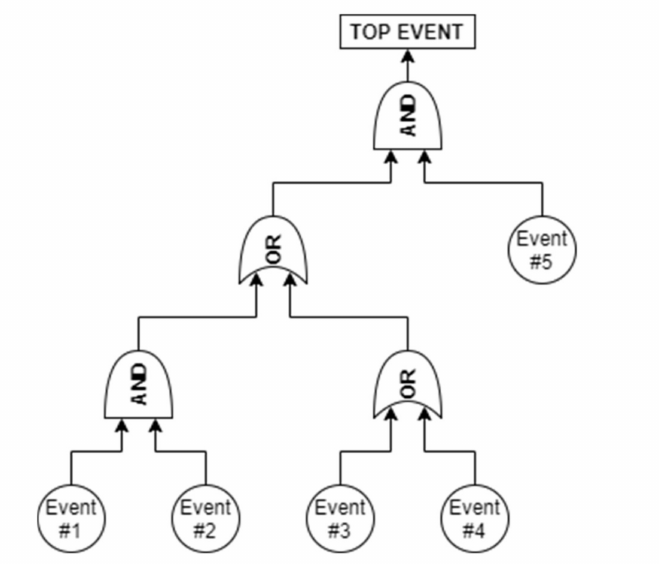
Figure 2. Main gates used in the Fault Tree Analysis: 2-input AND gate and 2-input OR